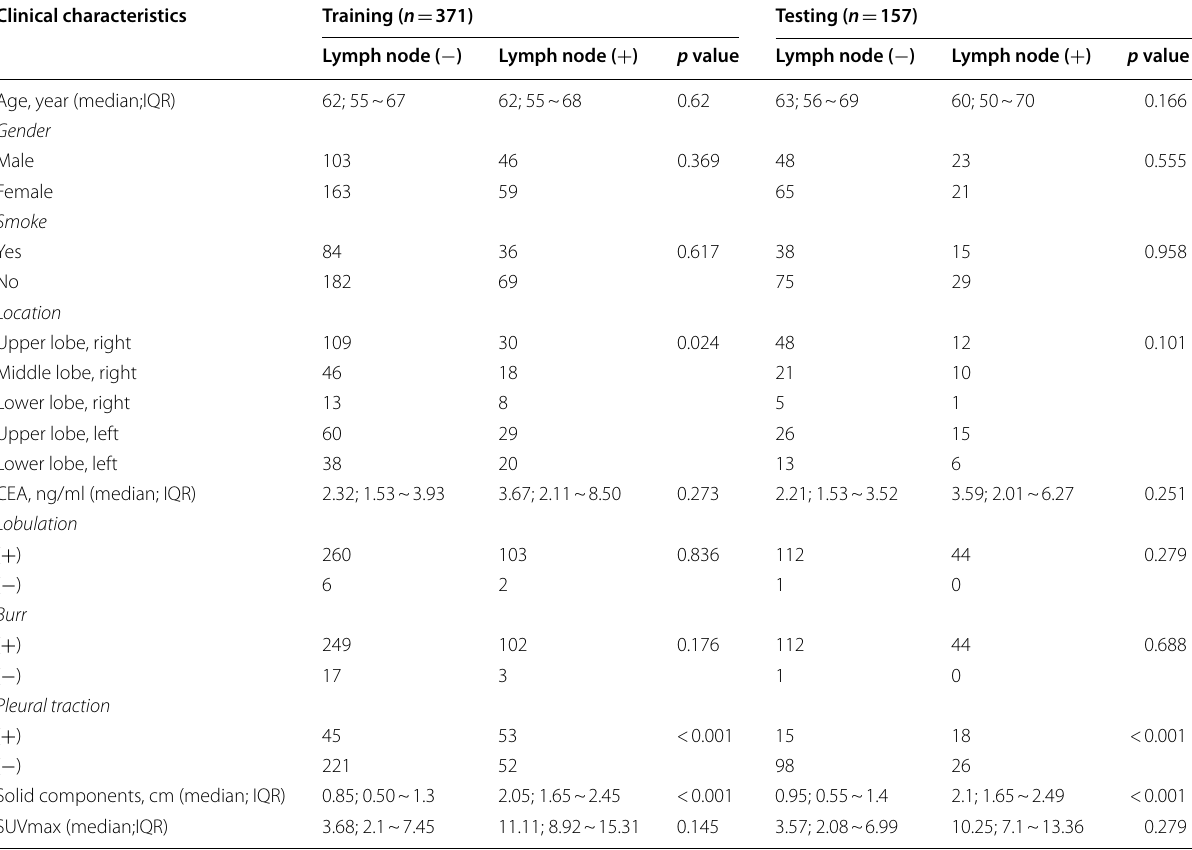
Table 1 Clinical features of 528 patients enrolled in this study Clinical